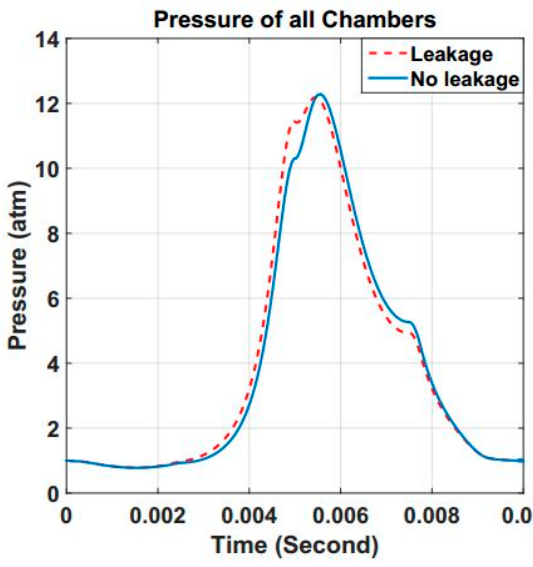
Figure 10. Pressure of working fluid vs. time over one cycle (100 Hz).